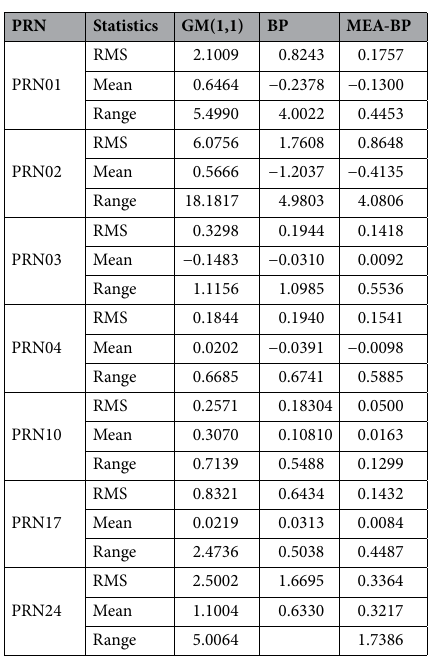
Table 8. Statistics of 12 h prediction results of the seven satellites (unit: